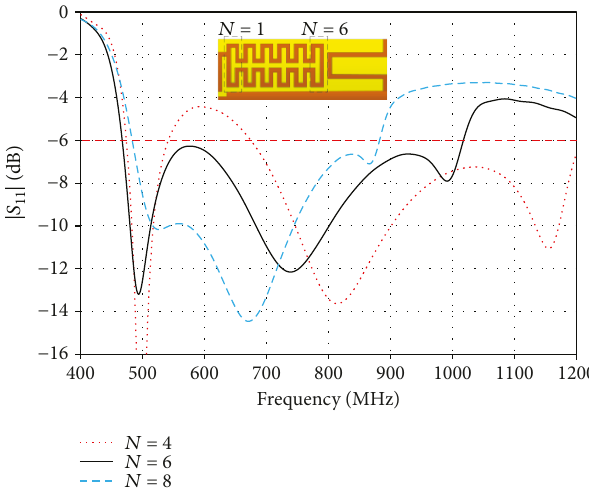
Figure 9: Simulated | S variable numbers of meandering turns ( N ).